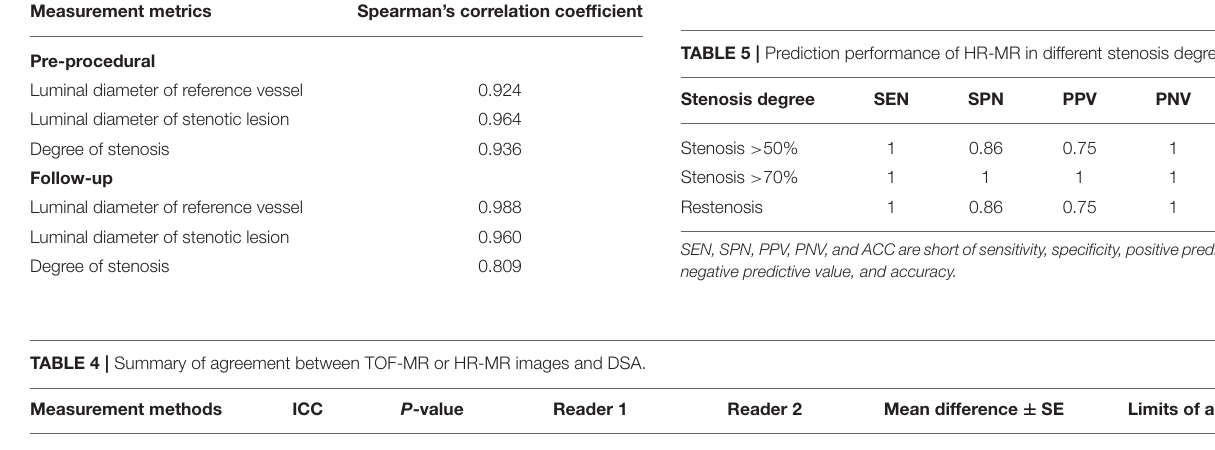
TABLE 3 | Correlation coefficient between digital subtraction angiography (DSA) and HR-MR in the different measurement metrics. Measurement metrics